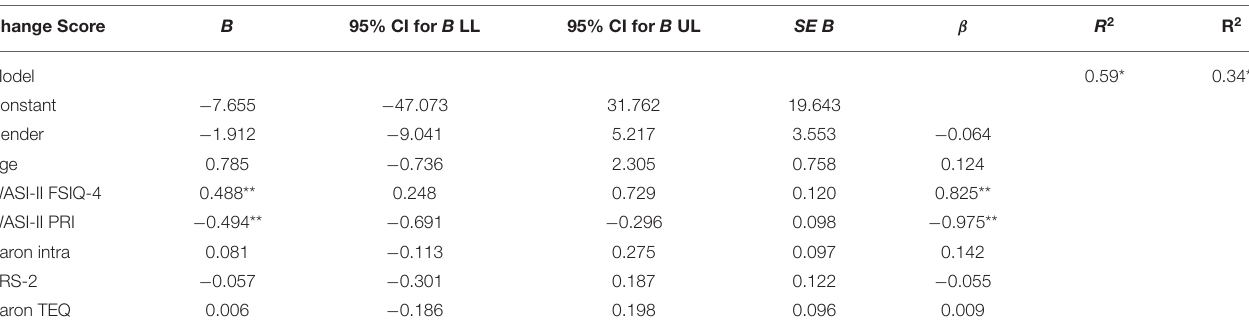
TABLE 2 | Multiple regression results for teen change